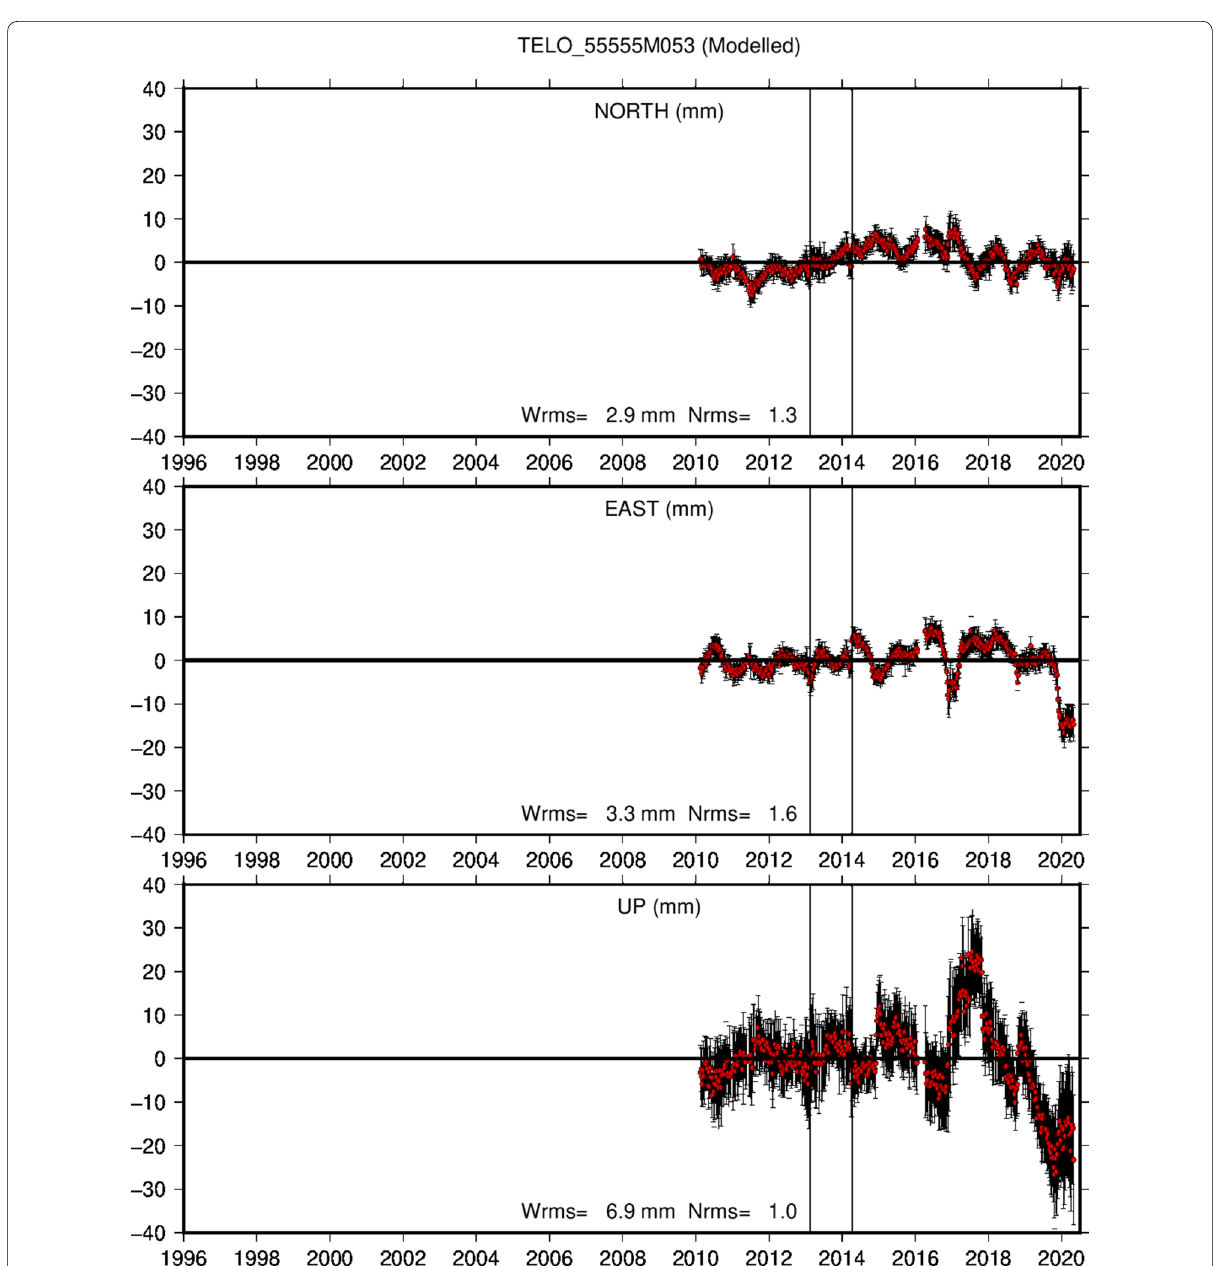
Fig. 7 Anomaly behavior in the east and vertical components of the position time-series at station TELO in Victoria, Australia, the position time-series generated after removing the plate motion model and outliers as well as offset